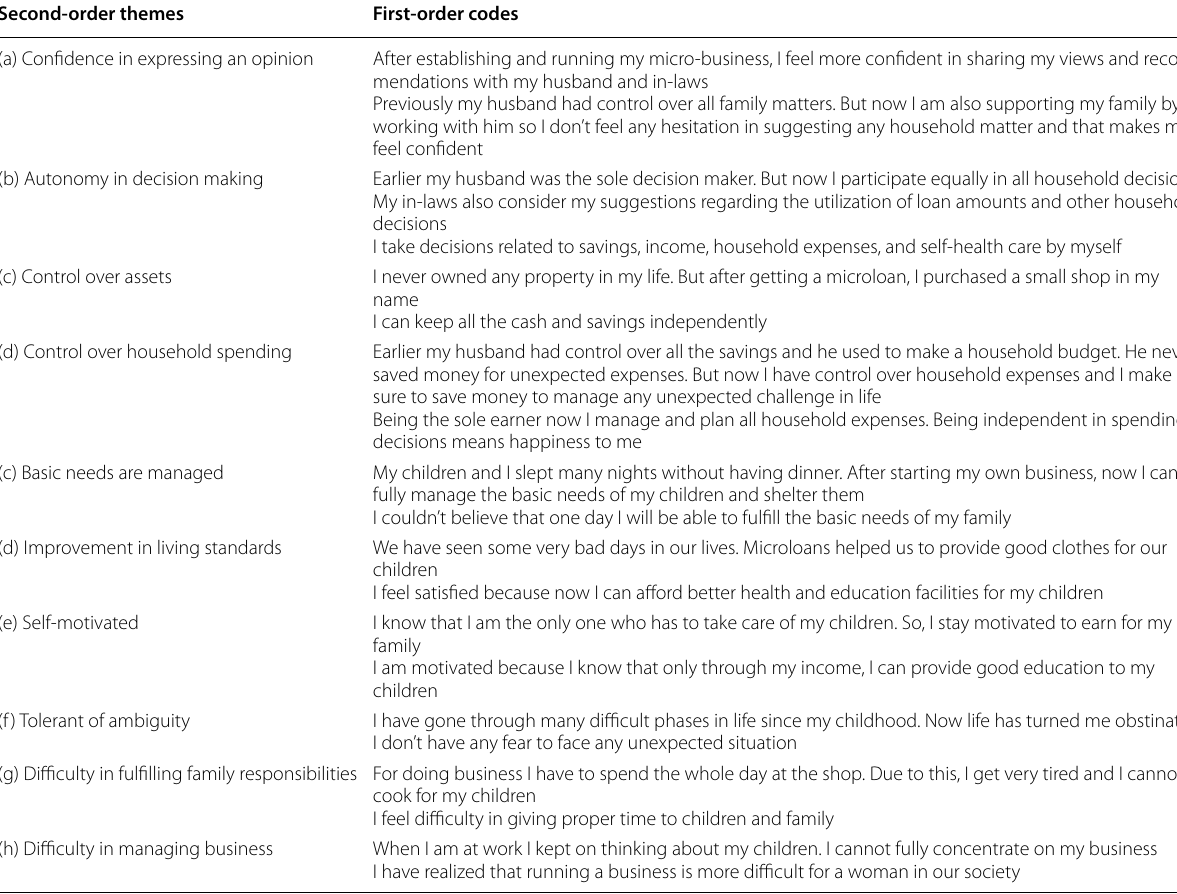
Table 4 Representative supporting data for each second-order theme Second‑order